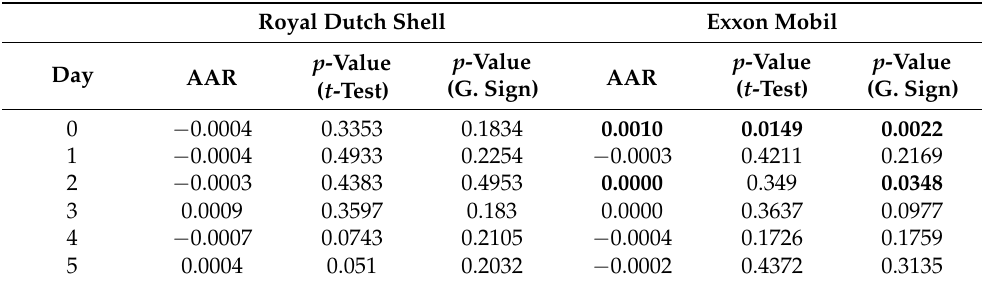
Table 1. Average abnormal returns Royal Dutch Shell and Exxon Mobil—Slochteren and Anadarko induced seismicity combined ( df = 726).